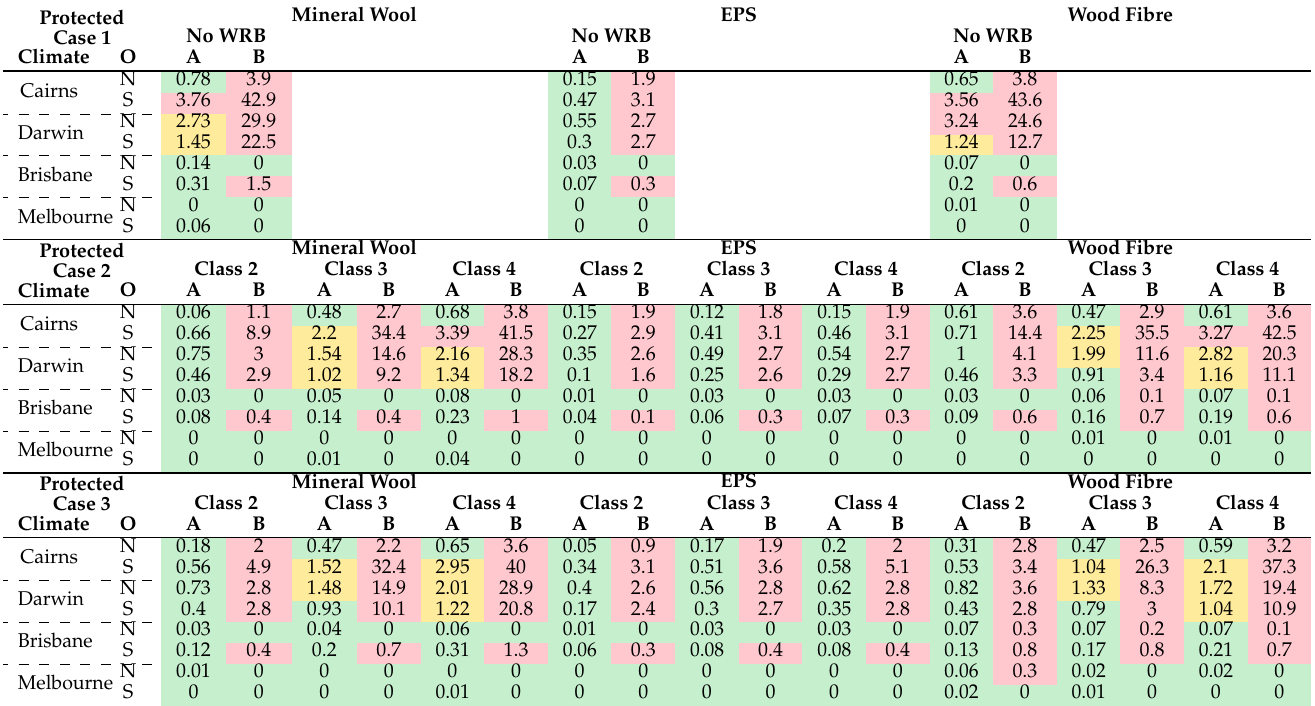
Figure 6. Wall assembly with exterior insulation. No WRB modelled (Case 1), WRB adhered to exterior of CLT panel (Case 2), and WRB installed to exterior of insulation layer (Case 3). Red points represent the monitoring positions at the internal and external surface of the CLT panel. Table 8. Protected CLT results for external insulation. O (orientation). Performance criteria: A (mould growth index), B (corrosion rate). Classification of WRB: Class 2, 3, and 4 (vapour permeance). Green (pass), red (fail), or yellow (further